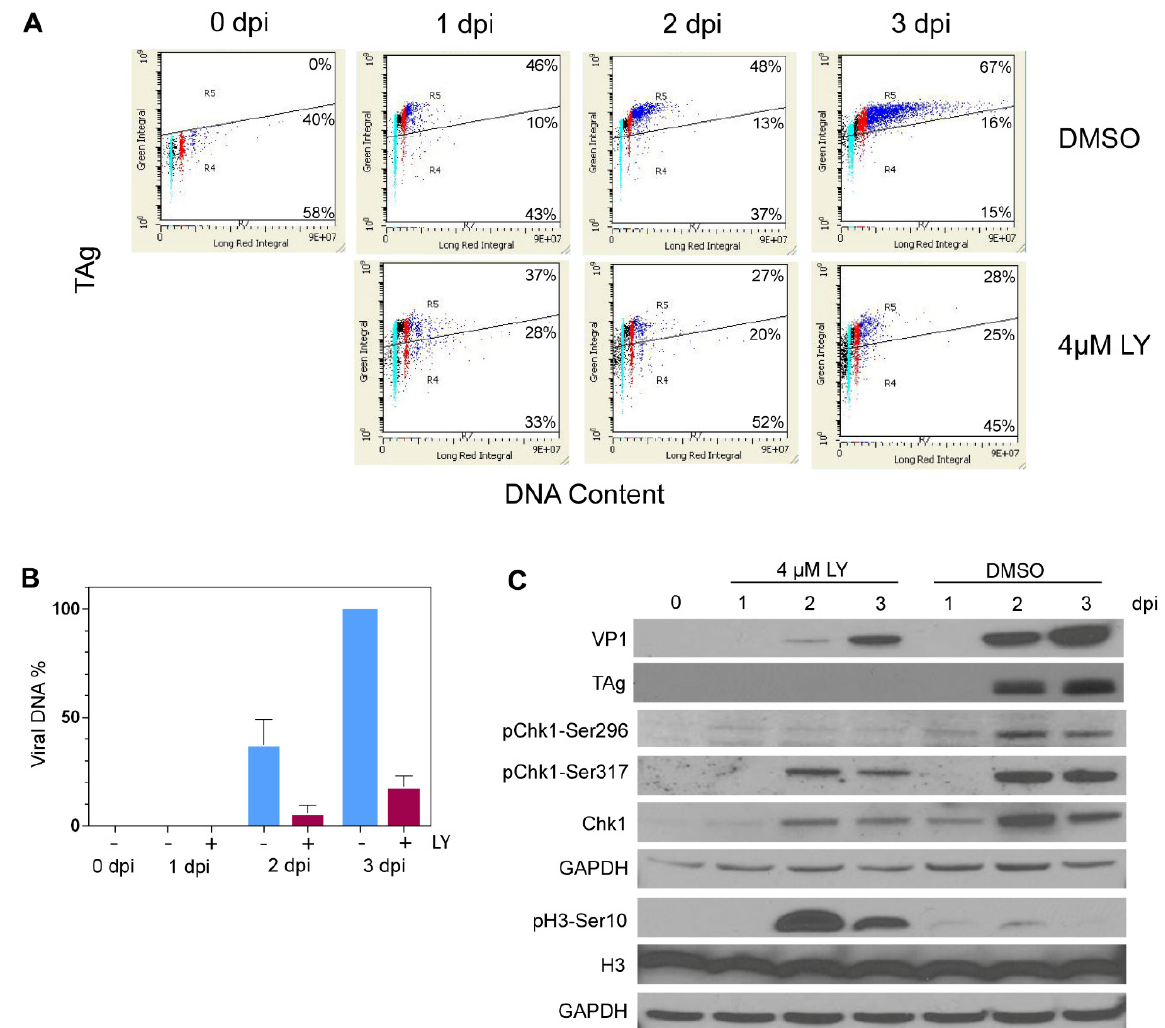
Figure 5. LY2603618 inhibits BKPyV DNA synthesis and progression of infected cells into >G2 phase. Quiescent RPTECs were infected with BKPyV (MOI = 10 IU/cell) for 90 min. The inoculum was removed and either 4 µM LY2603618 or 0.025% DMSO was added to parallel cultures. ( A ) Cultures were fixed on days 0 (uninfected), 1,2 and 3 post-infection. Fixed cells were stained with anti-SV40 TAg (PAb416) followed by Alexa 488 goat anti-mouse IgG. Cells were treated with RNase A and stained with propidium iodide prior to LSC analysis. Cell cycle position is color coded as follows: G1 phase—cyan, S phase—black, G2 phase—red and >G2 phase—blue. ( B ) Viral DNA was isolated from pooled floating and adherent cells using Qiagen miniprep spin-columns. The DNA was then linearized and resolved on ethidium bromide-containing agarose gels, imaged and quantified with Image J; DMSO (blue), LY2603618 (magenta); n = 3, error bars indicate standard error of the mean. ( C ) Whole-cell lysates were prepared from pooled floating and adherent cells by lysing in SDS-Page sample buffer and immunoblotting with the indicated antibodies; representative of n = 3.